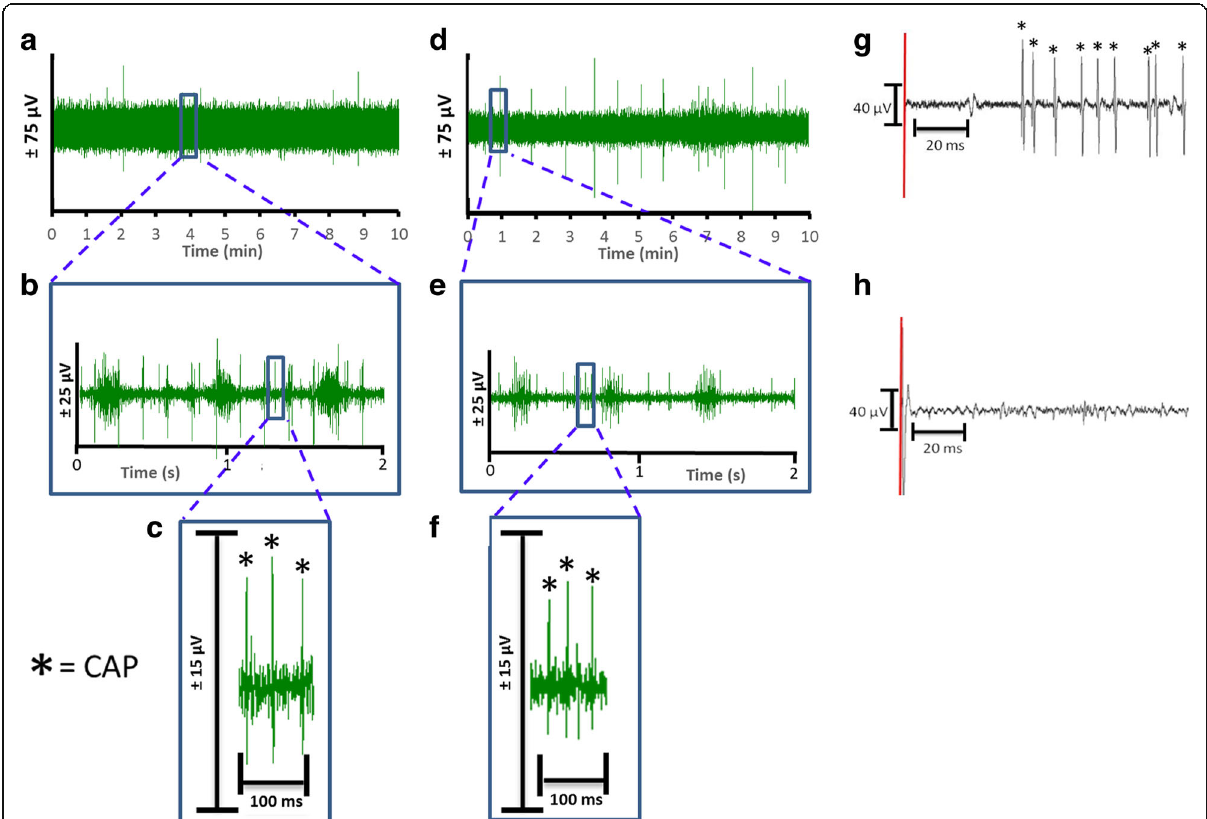
Fig. 2 Comparison of neurograms recorded with hook and cuff electrodes. Baseline activity from the cervical vagus nerve was recorded for 10 min from Balb/c mice with either a hook ( n =72) or a cuff ( n =25) electrode. a Representative recording of the neural signals by three hook electrode in a 10 min window, b ) The inset from ( a ) is expanded as a 2 s window, c ) The inset from ( b ) is expanded as a 100 millisecond window with CAP ’ s indicated by the asterisk. d Representative recording of the neural signals recorded by the cuff electrode in a 10 min window, e ) The inset from ( d ) is expanded as a 2 s window, and f ) The inset from ( e ) is expanded as a 100 millisecond window with CAP ’ s indicated by the asterisk. g Addition of KCl (4 mM) indicated by the red line directly to the cervical vagus nerve causes depolarization and CAP ’ s to fire (indicated by asterisk). h ) Pretreatment with 2% lidocaine inhibits the depolarization and subsequent CAP firing induced by the addition of KCl (4 mM) indicated by the red